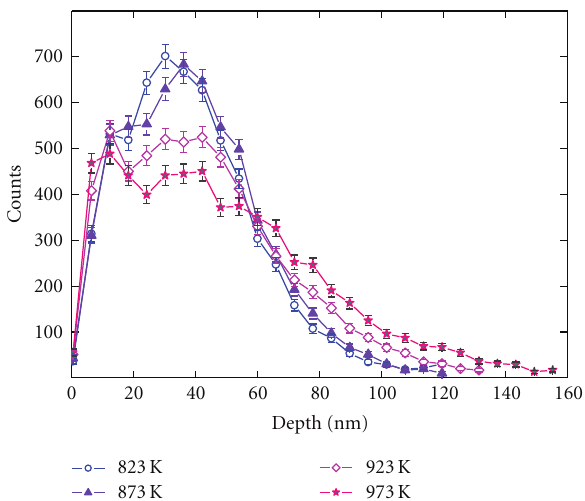
Figure 2: Depth profile of implanted nitrogen after annealing the same sample at 823 K, 873 K, 923 K, and 973 K for 30 min